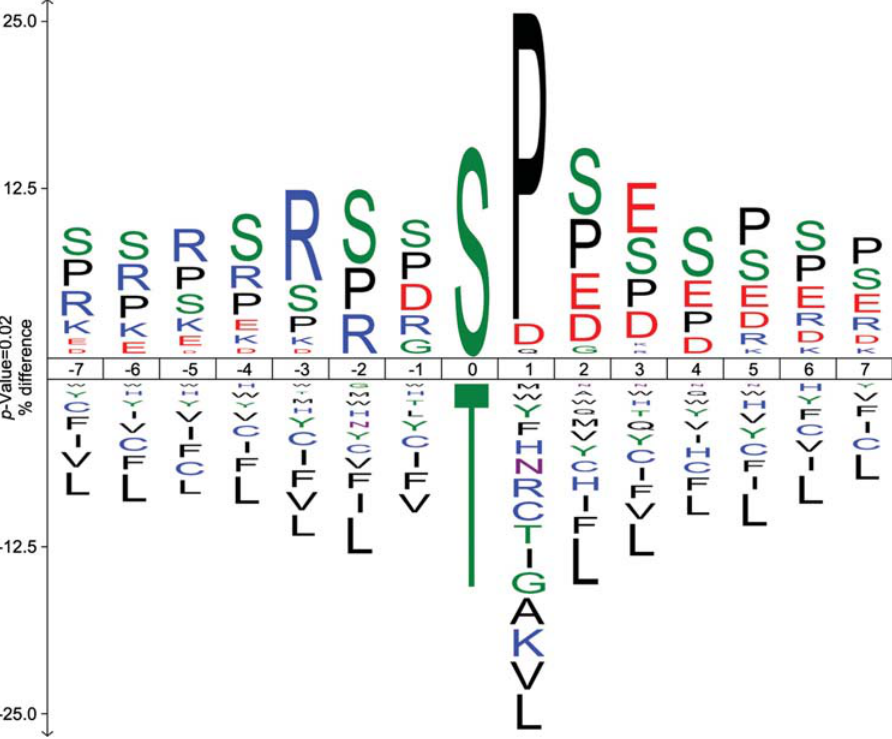
Figure 3 IceLogo analysis of S/T phosphoproteome vs. S/T proteome. IceLogo representation highlighting the different distribution of residues surrounding pS/pT with regard to the random distribution. Random and phosphopeptides are collected and analyzed as described in Methods